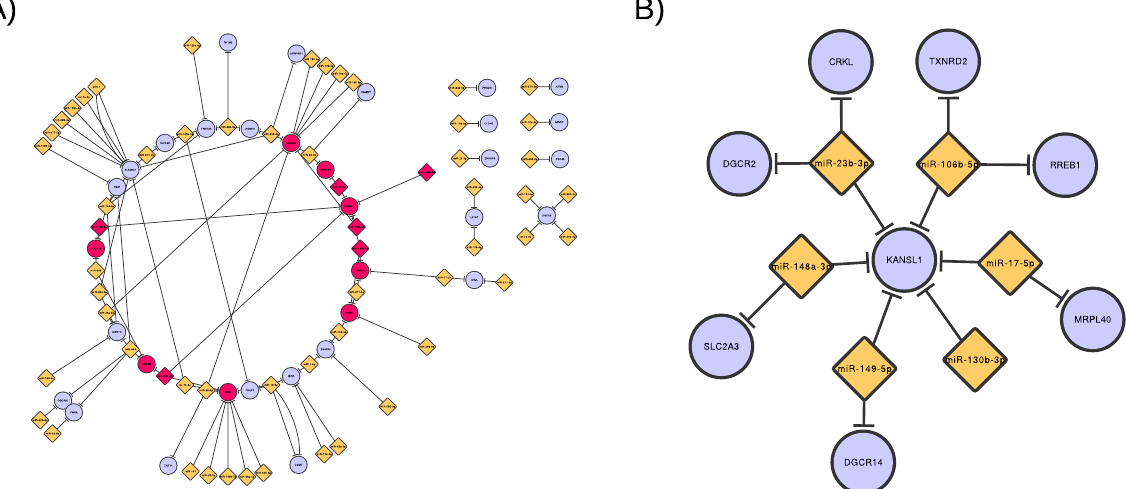
Figure 3. miRNA-mRNA interactions networks. The yellow diamonds represent miRNAs and the light purple, mRNA targets. The edge connecting two nodes indicate regulation. ( A ) The red filled nodes correspond to miRNAs, KANSL1 and genes of deletion co-regulated by the same miRNAs in the context of the whole network. ( B ) Sub-network showing only KANSL1 interacting module. The graphs were generated in Cytoscape 3.2 and drawing using the Circle